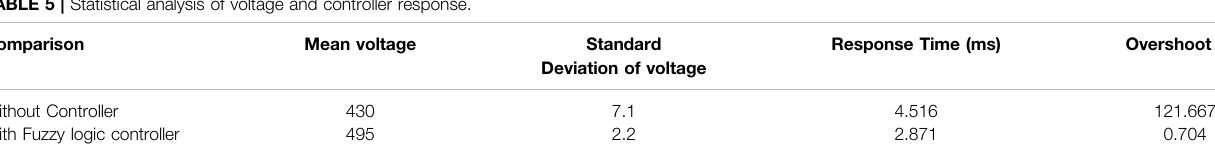
TABLE 5 | Statistical analysis of voltage and controller